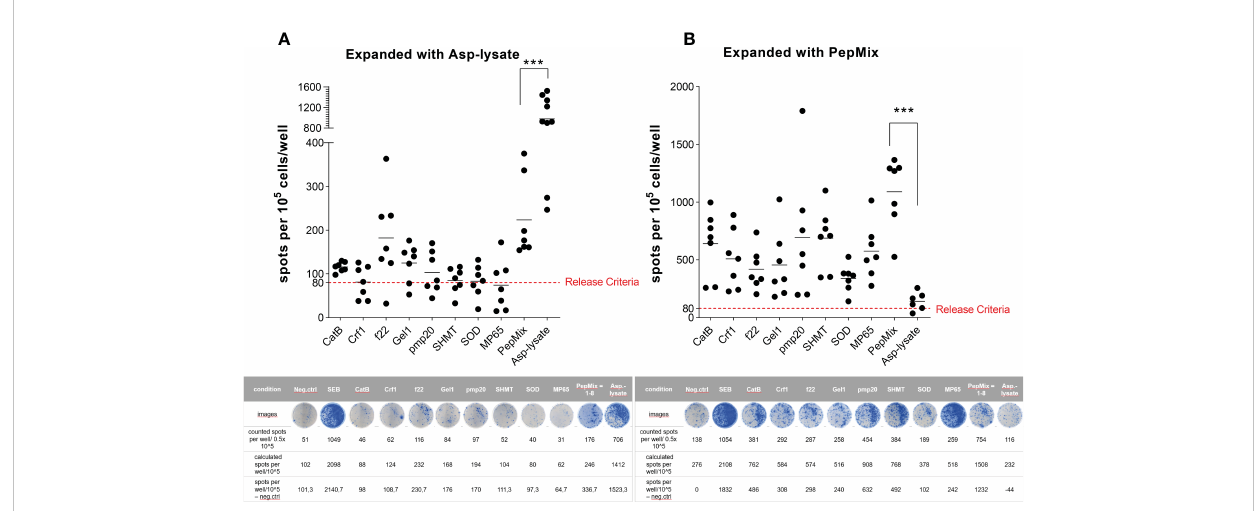
FIGURE 4 Functional activity of short-term expanded (STE) ATCs analyzed via IFN- g EliSpot assay. PBMCs were short-term expanded (STE) for 12 days with either the (A) Asp-lysate (50 µg/ml) or the (B) combination of eight fungal peptide pools termed PepMix (1 µg per peptide/ml per peptide pool, composed of: CatB, Crf1, f22, Gel1, pmp20, SHMT, SOD and MP65 peptide pool). A) Numbers of IFN- g spots per 10 5 cells/well of lysate-expanded ATCs (including mean values) after restimulation for 16 hours with either Asp-lysate (n=9), single peptide pools (n=7), or PepMix (n=7), as indicated, are shown. B) Numbers of IFN- g spots per 10 5 cells/well of PepMix-expanded ATCs (including mean values) after restimulation for 16 hours with either the Asp-lysate (n=6), single peptide pools (n=7), or the PepMix (n=7), as indicated, are shown. For analyses of spots per well, background values were subtracted. The cut-off criterion (red dotted line) for a clinical product were set to 80 spots/10 5 cells. Data are shown in total as individual result and mean of healthy individuals from our cohort of donors (n=320). Representative EliSpot results are shown below the respective graph. Statistically signi fi cant difference is indicated by